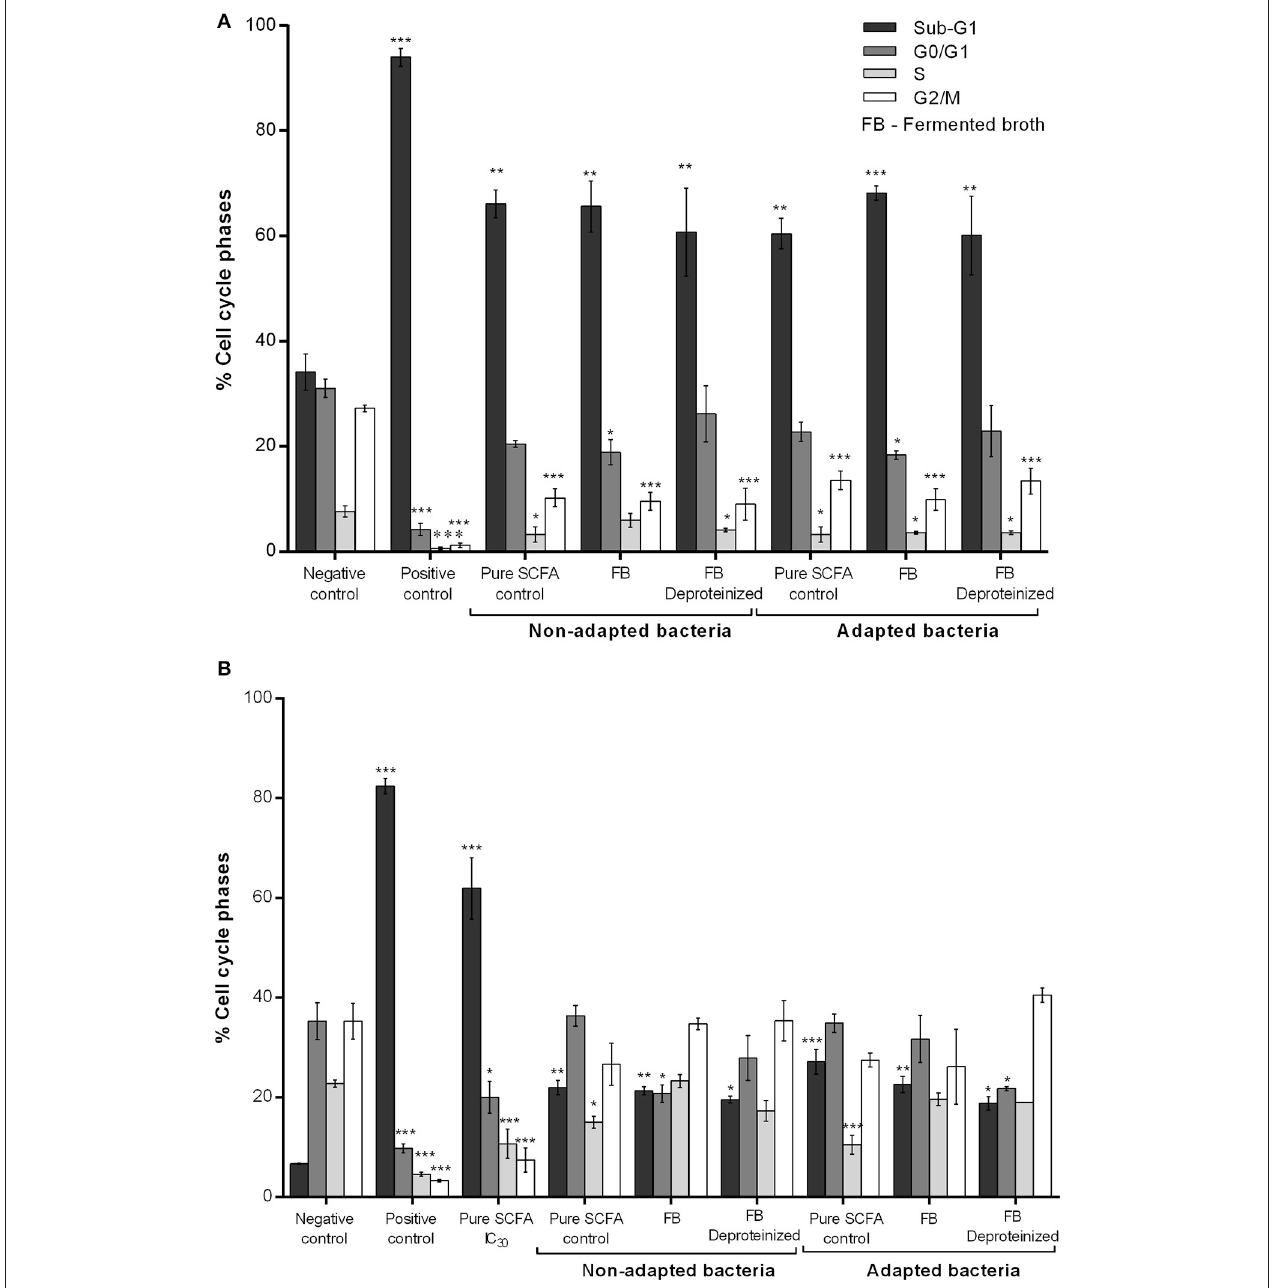
FIGURE 5 | Effect of the BM (A) and DMEM (B) fermented broth on cell cycle distribution. Analysis of the cell-cycle phase’s distribution: G0/G1; S; G2/M and SUB-G1 in CRC cells treated with fermented broth from adapted and non-adapted P. freudenreichii and the respective controls. Fermented broths were deproteinized to eliminate any possible cytotoxic effect from contaminating proteins. BM diluted in fresh DMEM medium and CRC cells conditioned medium diluted in fresh DMEM medium were used as a negative control of BM and DMEM fermented broths, respectively. Hydrogen peroxide (1mM) was used as a positive control. Pure SCFA at concentrations present on the fermented broth of non-adapted bacteria (0.9g L − 1 acetate; 2.4g L − 1 propionate) or adapted bacteria (0.6g L − 1 acetate; 1.5g L − 1 propionate) were used as a SCFA control. Values represent the mean ± standard error of the mean of at least three independent experiments. * p < 0.05; ** p < 0.01; *** p < 0.001, comparing with negative control.